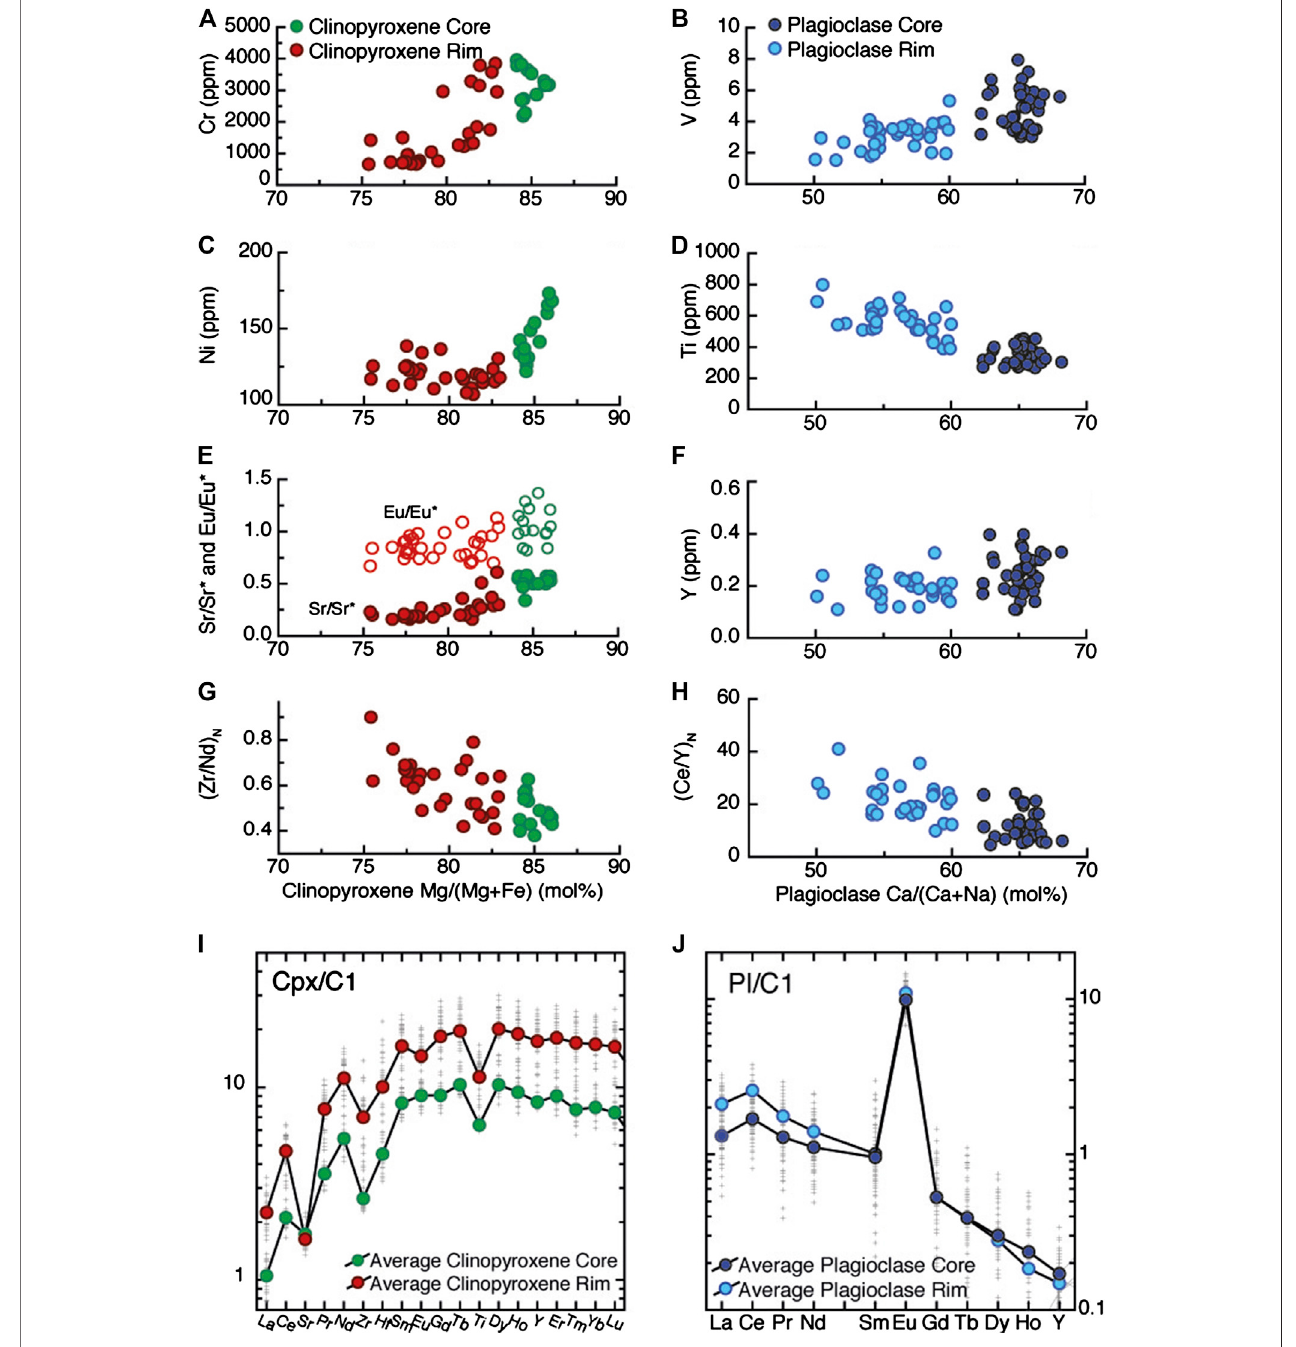
FIGURE 5 | General trace element variability of clinopyroxene and plagioclase from the entire thin section. Clinopyroxene (Cpx) Mg/(Mg + Fe) (mol%) vs. Cr, Ni (ppm), Sr/Sr* (cid:1) Sr N [ √ (Ce N xNd N )], Eu/Eu* (cid:1) Eu N [ √ (Sm N xGd N )](Zr/Nd) N ratios. Plagioclase (PL)Ca/(Ca +Na)(mol%) vs. V,Ti, Y(ppm) and (Ce/Y) N ratio.Chondrite(C1)- normalised (Andersand Ebihara, 1982) incompatible trace element patterns of each point (grey cross) and average Cpx-Core and Pl-Core and Cpx-Rim and Pl-Rim are also depicted. The different generations of Pl and Cpx are de fi ned on the basis of the chemical pro fi les in Figure 4 and Supplementary Figure S1 .